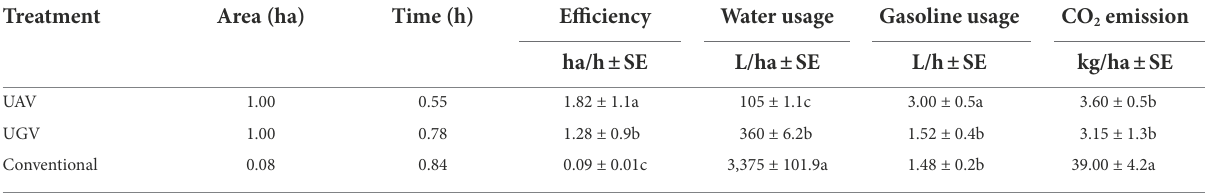
TABLE 3 Comparison of the working efficiency and resource consumption of different spraying technologies.